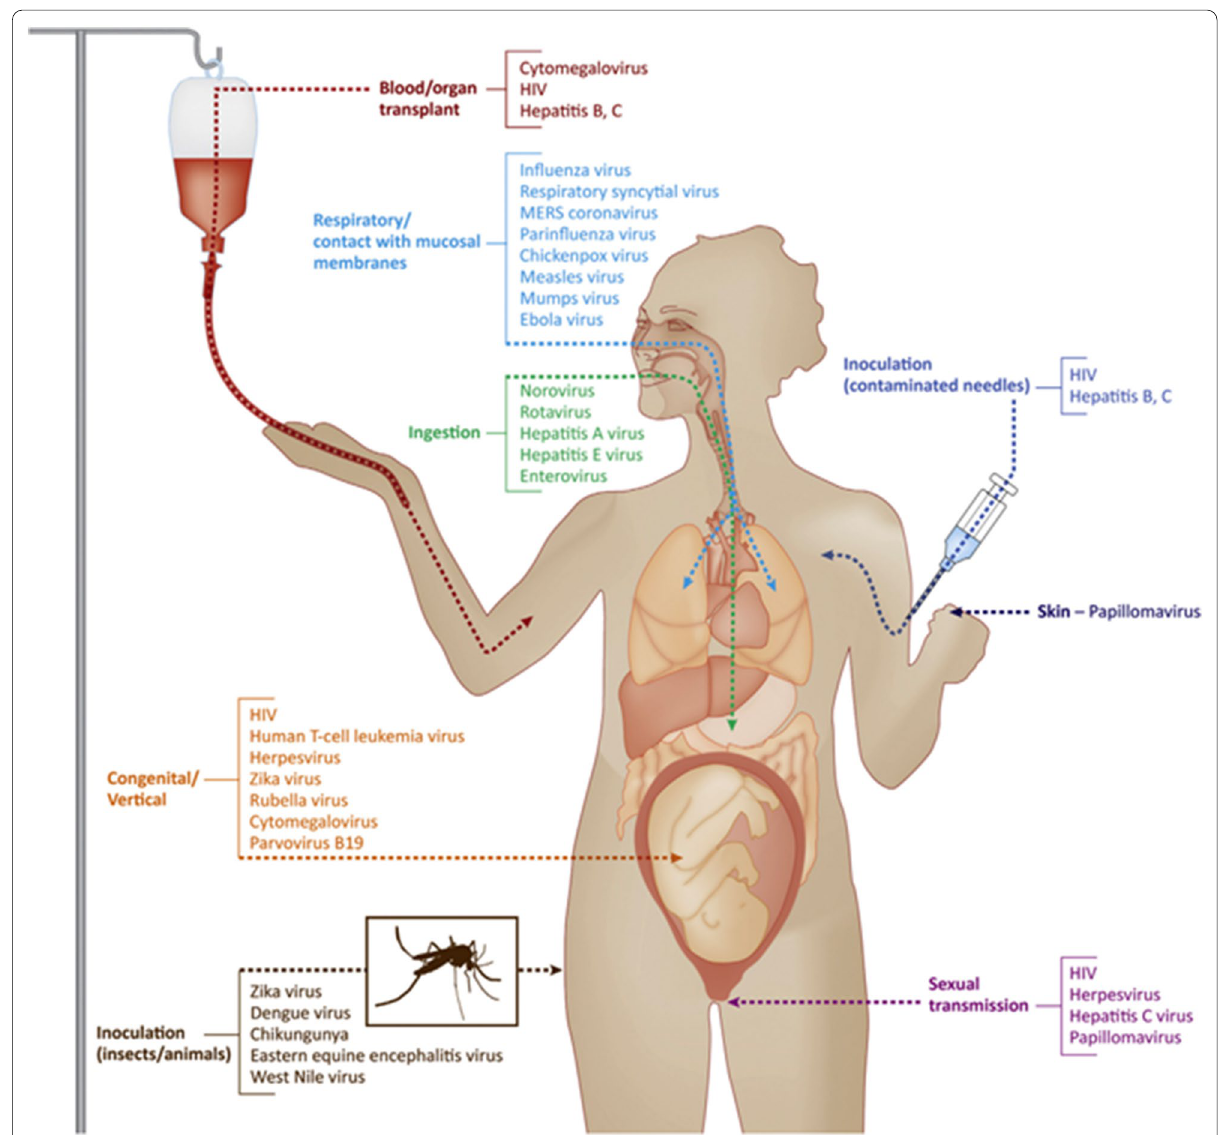
Fig. 2 General entry routes of viruses [27]. Reproduced with permission. Copyright © 2017, Elsevier